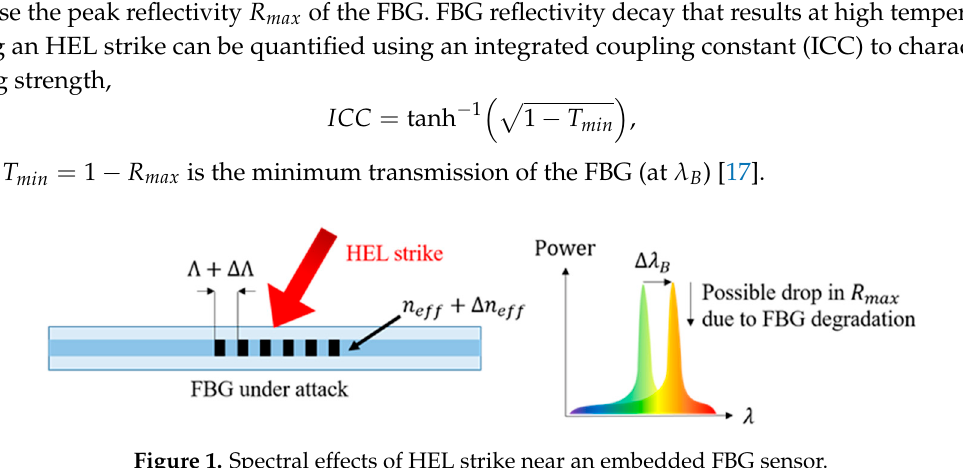
Figure 1. Spectral effects of HEL strike near an embedded FBG sensor.